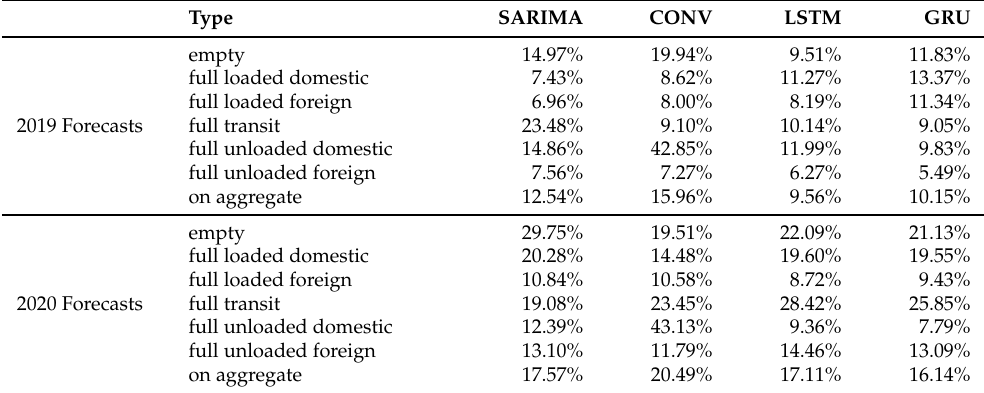
Table 3. Forecasting MAPE results for SARIMA, CONV, LSTM, and GRU models in 2019 and 2020.